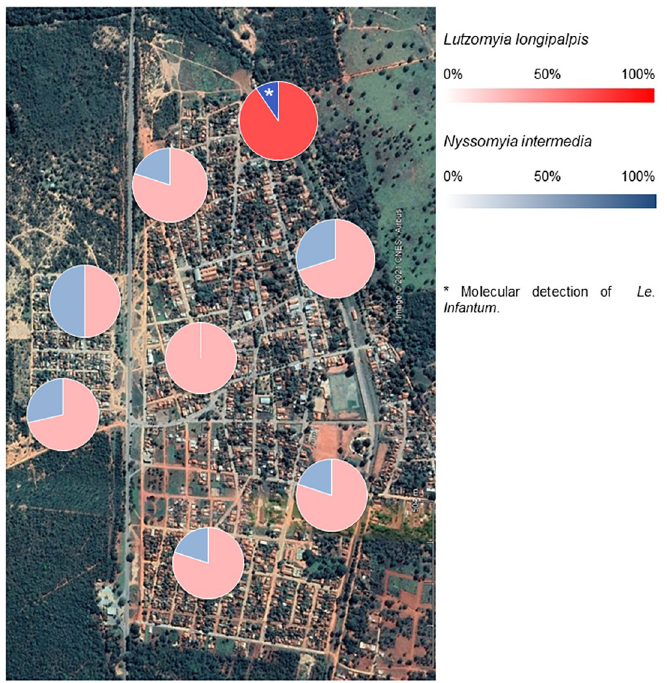
Fig 5. Risk areas based on distribution of incriminated leishmaniasis’ vector sand flies species captured among the sample points in Lassance